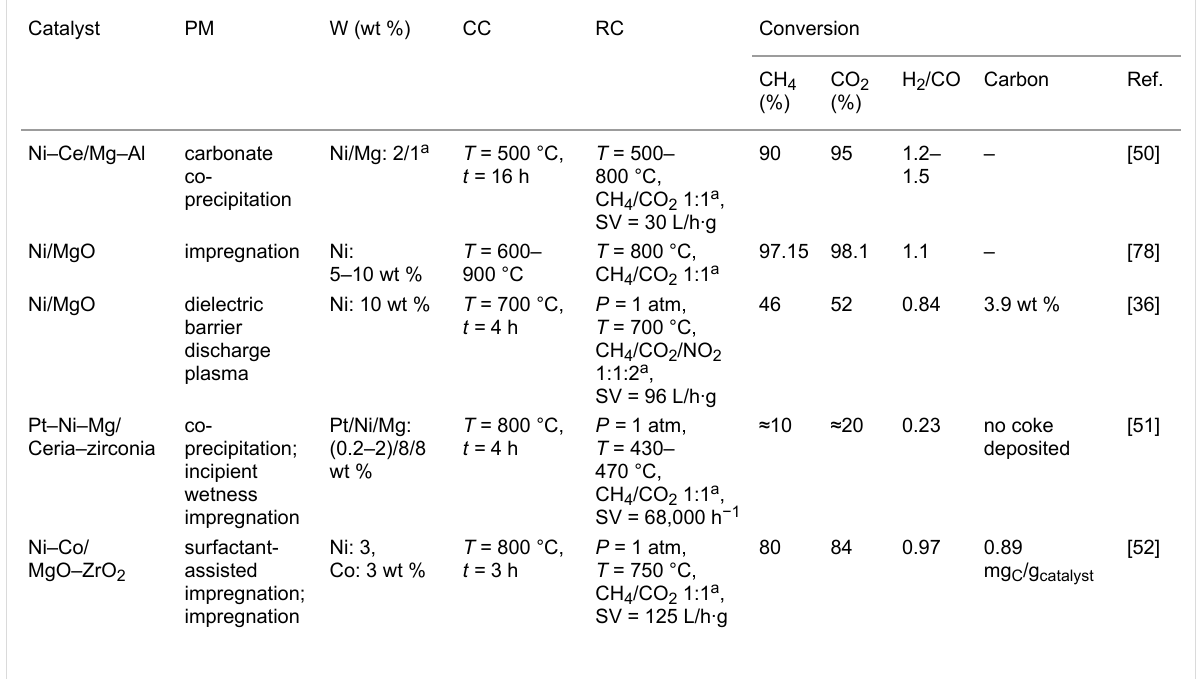
Table 3: Literature summary on the development and process conditions of Mg-containing oxide catalysts in DRM. PM: Preparation method; W: metal loading; CC: calcination conditions; RC: reaction conditions; SV: space velocity.